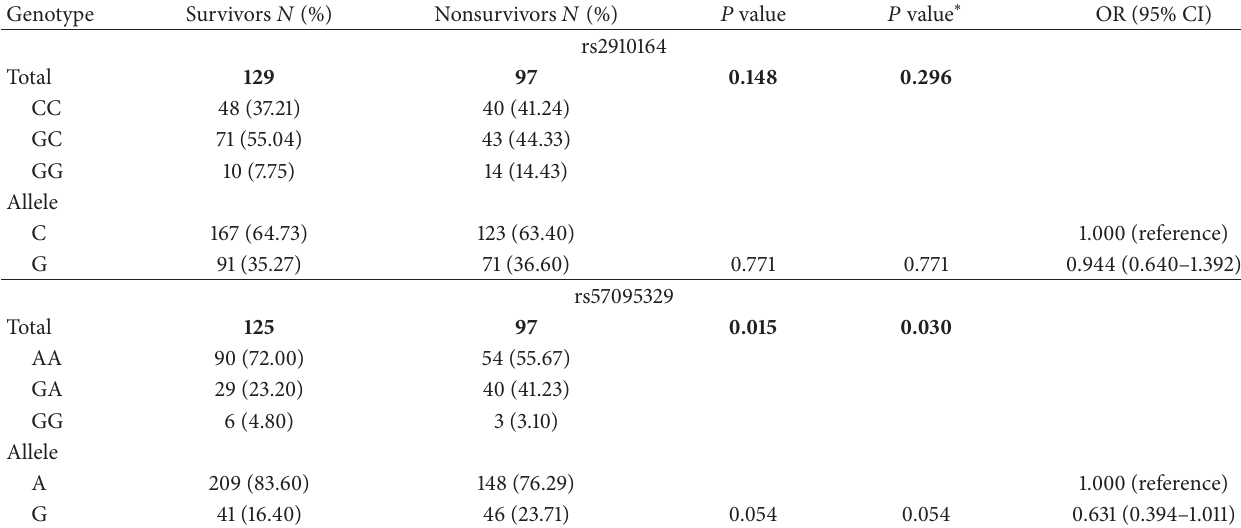
Table 4: Genotype and allele frequencies distribution in surviving and nonsurviving